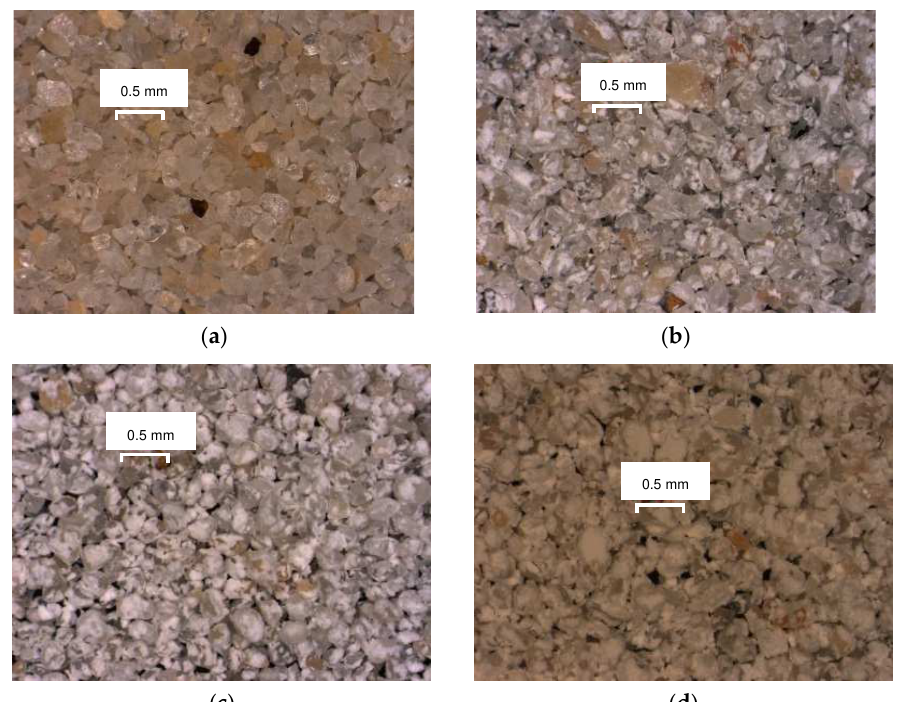
Figure 4. ( a ) Clean Hostun sand and sand mixed with ( b ) 5%, ( c ) 10% and ( d ) 20% quartz fines used in the present study.